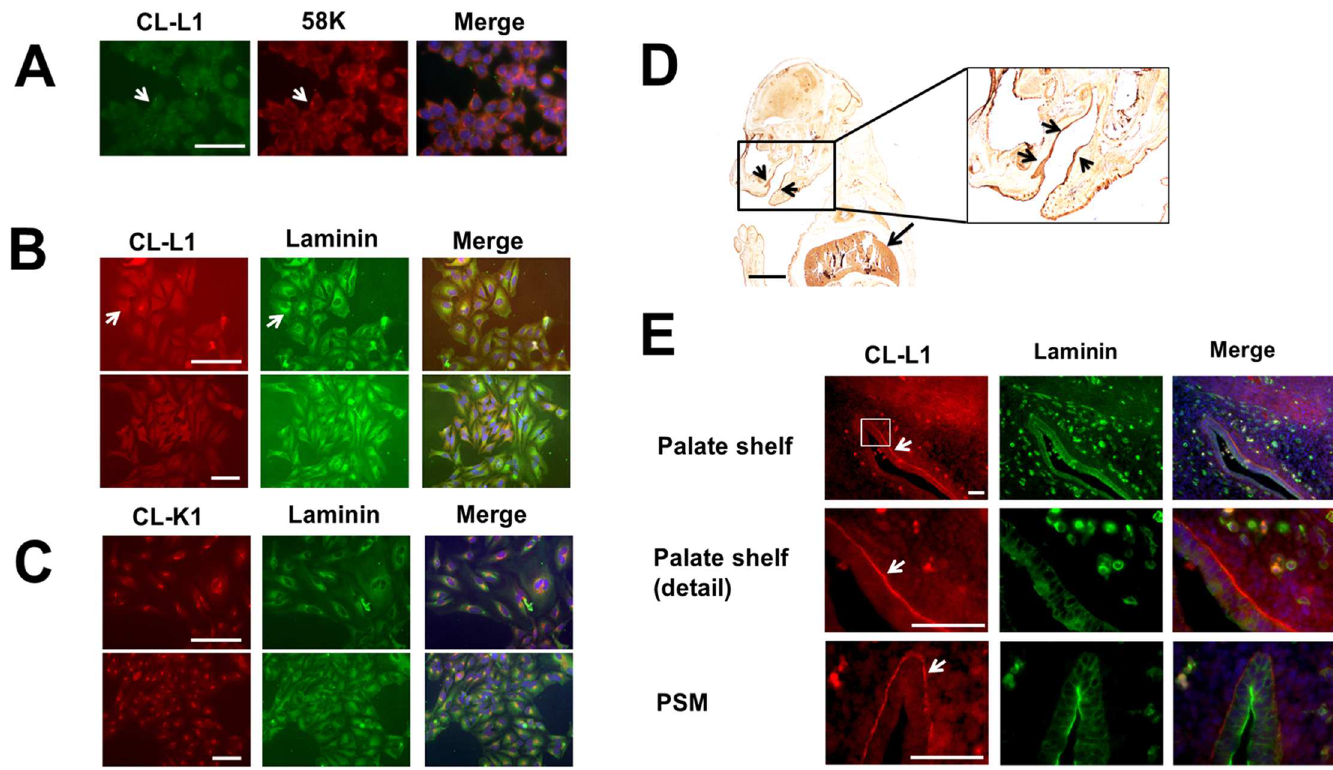
Fig 2. Cellular and embryonic localisation of CL-L1. A. Immunostainingof ATDC5 cells with the golgi marker 58K and CL-L1. CL-L1 shows localisation with golgi apparatus(white arrow). B. Lamininand CL-L1 coimmunolocalisation.Lamininshows partial cellularimmunolocalisiton with CL-L1 aroundthe golgi area (arrows). Scale bar 50 μ m C. Lamininand CL-K1 coimmunolocalisation. CL-K1 staining shows a very strong golgi localisation with partial cytoplasmatic laminincolocalisation. D. CL-L1 immunohistochemistry of a 18.5 days postfertilisation mouse embryo. CL-L1 is expressedin the liver (long arrow) and submucosal patal region(short arrows). E. Immunofluorescence showingco-localisation of CL-L1 and Lamininin E13.5 mouse embryos sections. CL-L1 is expressedin the basal membraneof the ephitheliumin the palate shelf of the maxilla(arrows). In contrast Lamininexpressionis present all aroundthe ephiteliummembrane. A faint but clear CL-L1 expressionis also observed in the cytoplasm of the epithelium and in the mesenchyme of the palate. PSM; rostral extremity of right palatalshelf of maxilla. Scale bar 100 μ m.